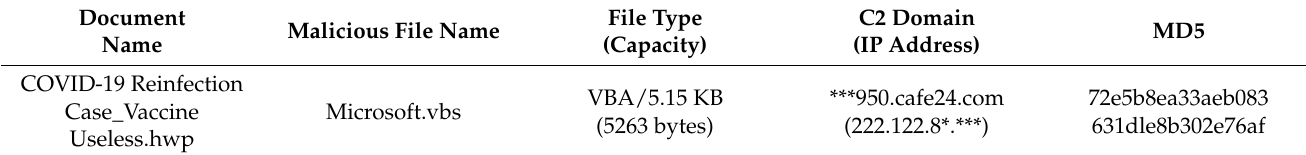
Table 5. Property information of malicious HWP documents and malicious OLE